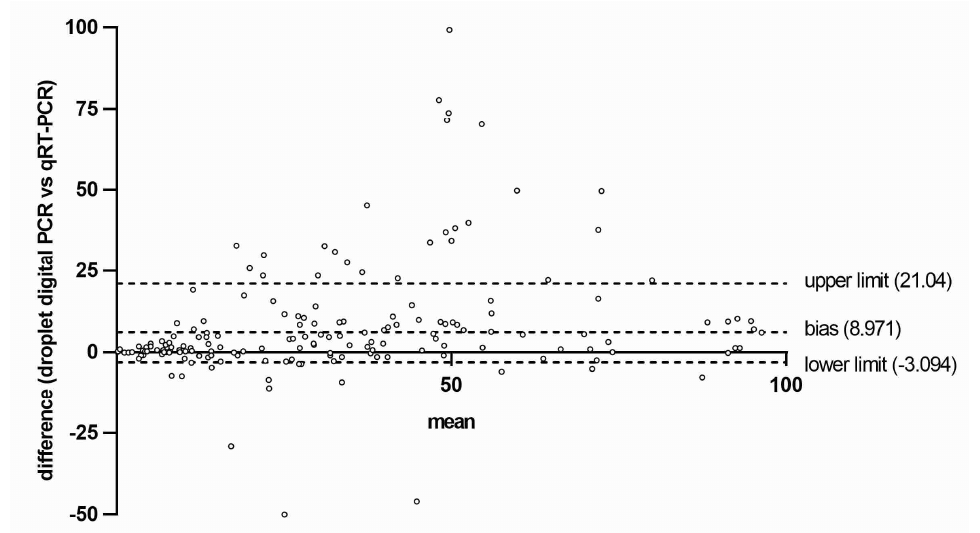
Figure 2. Correlation between qPCR and ddPCR.